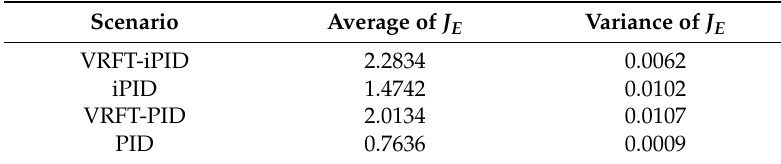
Table 3. Objective function values in experimental case study (3).